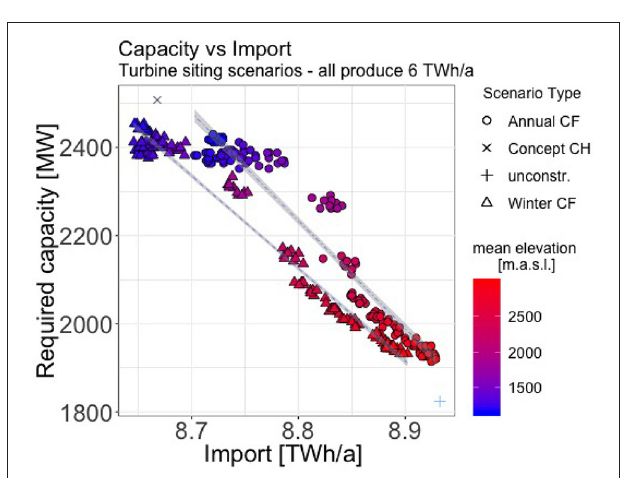
FIGURE 9 | Various random subsets of the COSMO-1 pixels to reach 6 TWh/a wind power production. Also included in this Figure are a scenario based on the Swiss Wind Energy Concept Bundesamt für Raumentwicklung (2017), “Concept CH,” as well as a scenario without constraints on elevation or locations (“unconstr”). Two regression lines are shown, one for the elevation-dependent winter capacity factor scenario-set and one for the elevation-dependent annual capacity factor